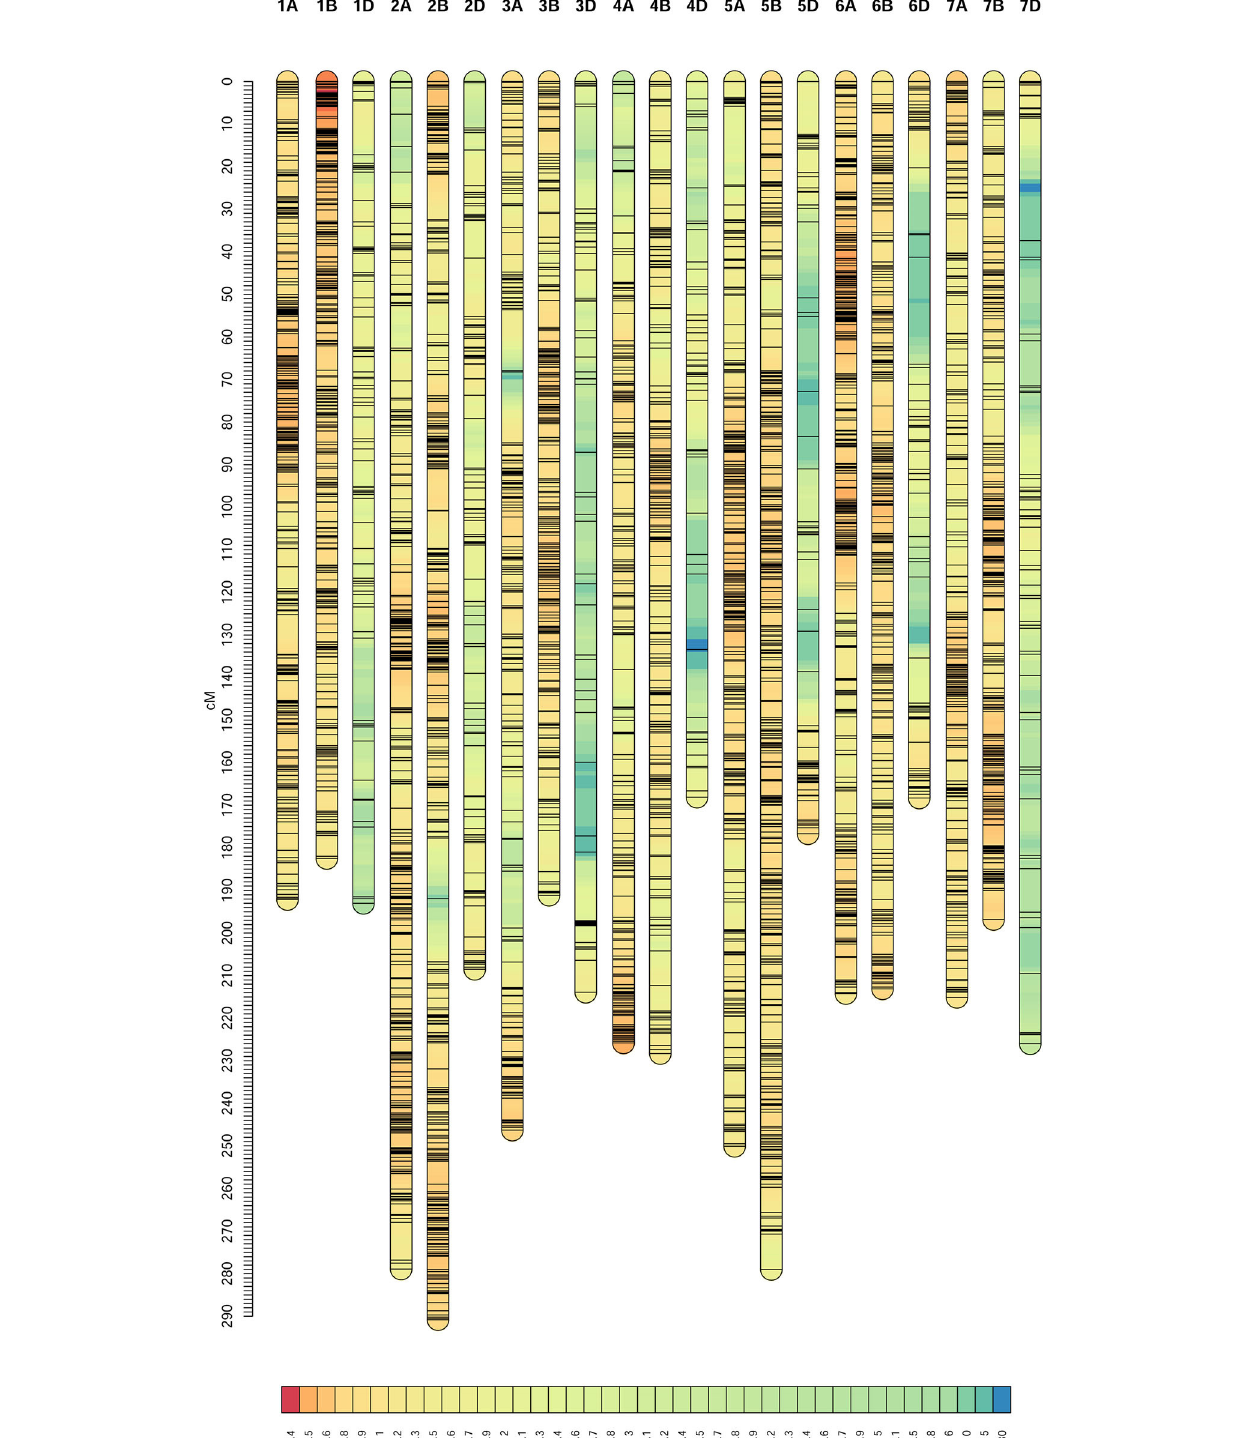
Frontiers in Plant Science |